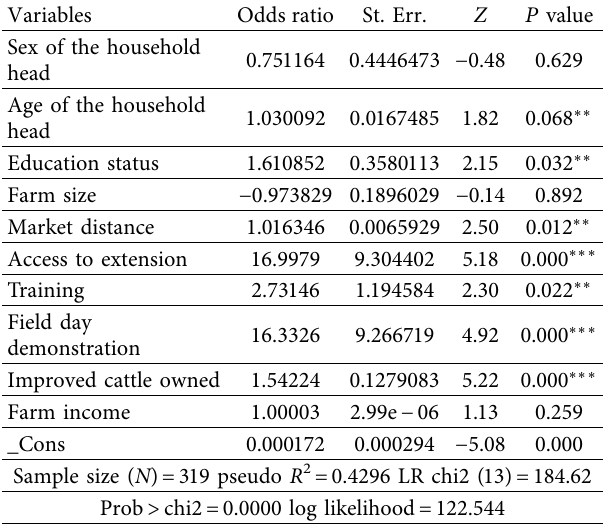
Table 5: Propensity score